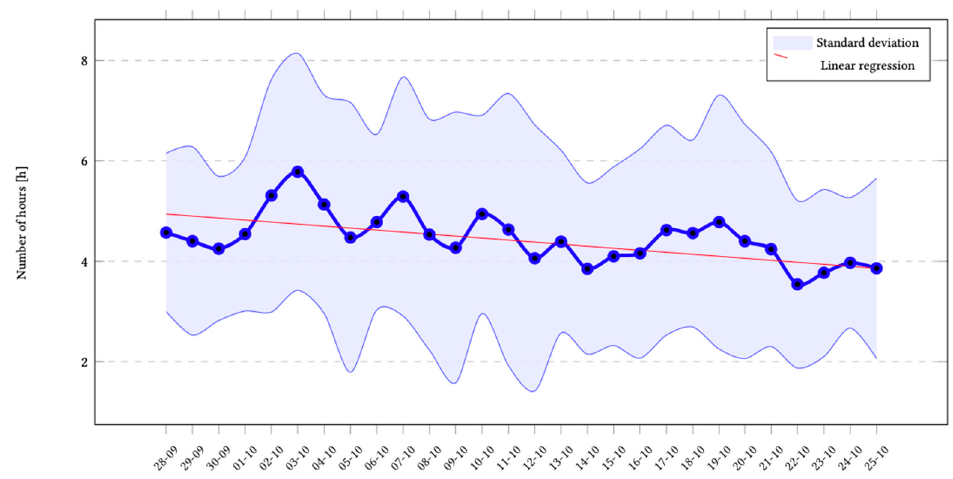
Figure 5. Average usage data, for each user, filtered by day. It is possible to observe that the linear trendline decreases, which indicates a reduction of smartphone use over the time. Filled blue areas as standard deviation.